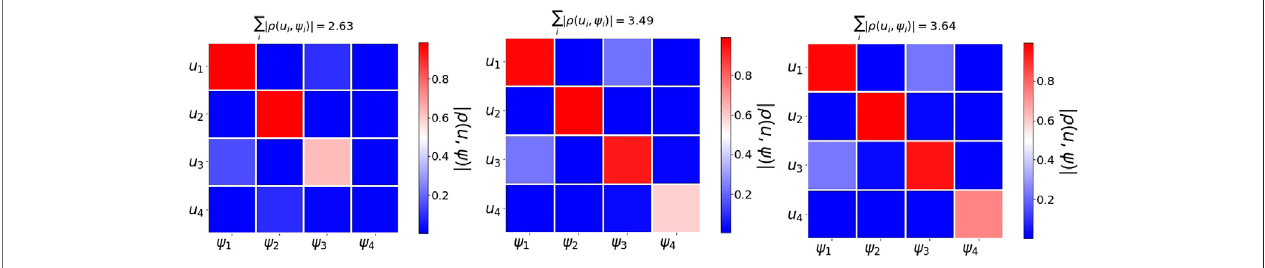
FIGURE 8 | Word2vec embedding of a collection of Gaussians. We use 2,500 points generated according to fi ve distinct Gaussians N ( r · i · 1 , 2 · I ) , where 1 is a 10 − dimensionalallonesvector,and r isscalarthatcontrolstheseparationbetweentheGaussiancenters.The fi gureshowstheabsolutecorrelation between u 1 , ... , u 4 and ψ 1 , ... , ψ 4 for r (cid:2) 8 , 9 , and10. For each value of r , we compute the sum of diagonal elements in the correlation matrix. This results demonstrate the strong 1 . agreement between word2vec embedding and the spectral representation based on P − 1 n